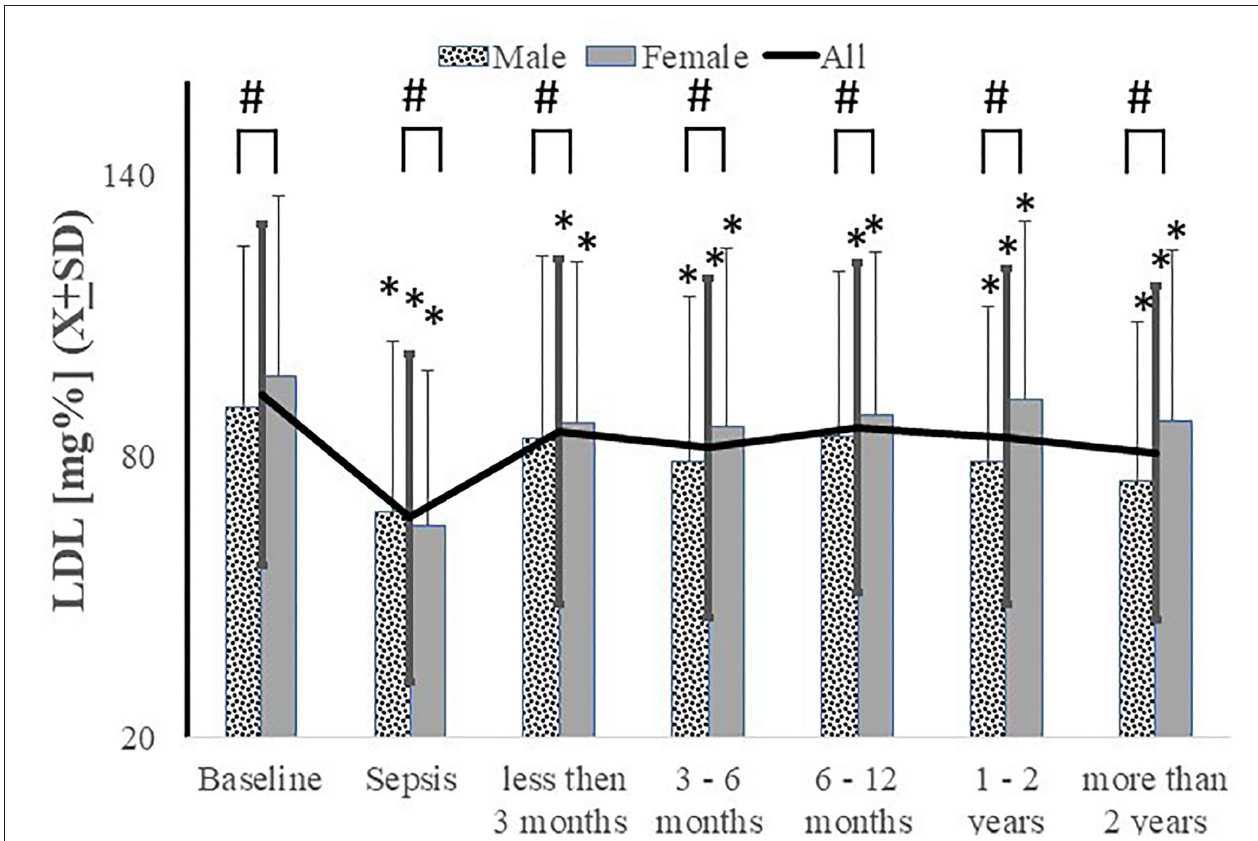
FIGURE 3 | Serum LDL levels were decreased acutely during sepsis and never recovered to pre-sepsis level with significantly less recovery in male subjects. * p < 0.05 as compared to baseline, # as compared between